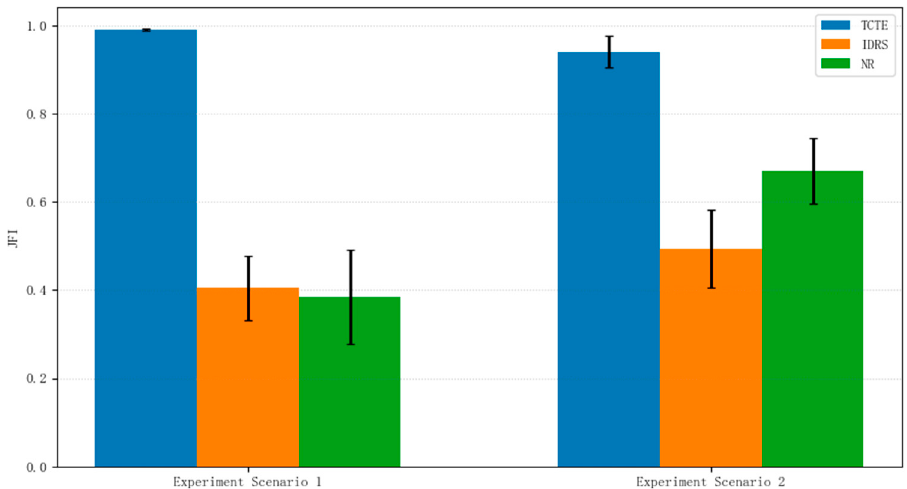
Figure 11. Mean and con fi dence intervals for JFI.